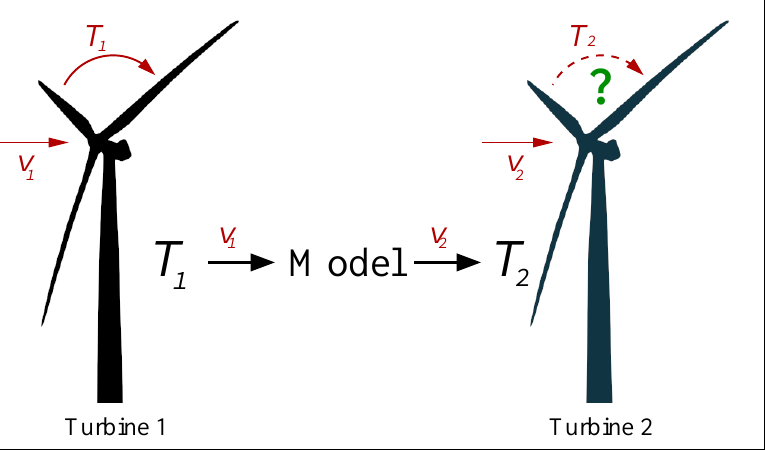
Figure 1. Sketch of the proposed idea for estimating fatigue loads: one derives a stochastic model from the data series of the wind speed and torque measured at Turbine 1. Using this model and the wind speed series measured at Turbine 2, one reconstructs the statistics of the torque at Turbine 2. From the estimated torque series, one estimates the fatigue